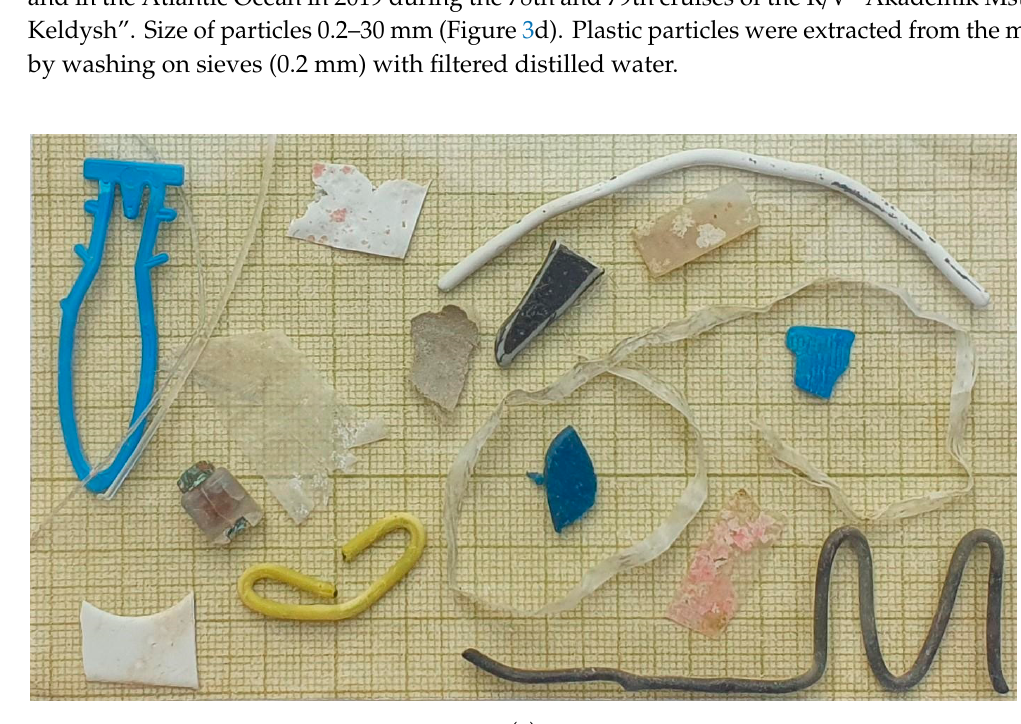
( b ) ( c ) ( d ) Figure 3. Examples of marine plastic litter collected at: ( a ) beach and coastal seawater on Crete; ( b ) marine sediment in the Eurasian Arctic Ocean; ( c ) Oslofjord beaches; ( d ) sea surface water in the Eurasian Arctic Ocean. 3. Results The reproducibility and data transferability were evaluated by collecting spectra of several reference material polymers from different manufacturers, with different particles size, and distance to the instrument’s lamps and detector by three different MicroNIR instruments connected to three different laptops. As shown in Figure 4, the different conditions of spectra acquisition do not affect the results and data obtained with different instruments, and computers can easily be merged in one database. ( a ) ( b )